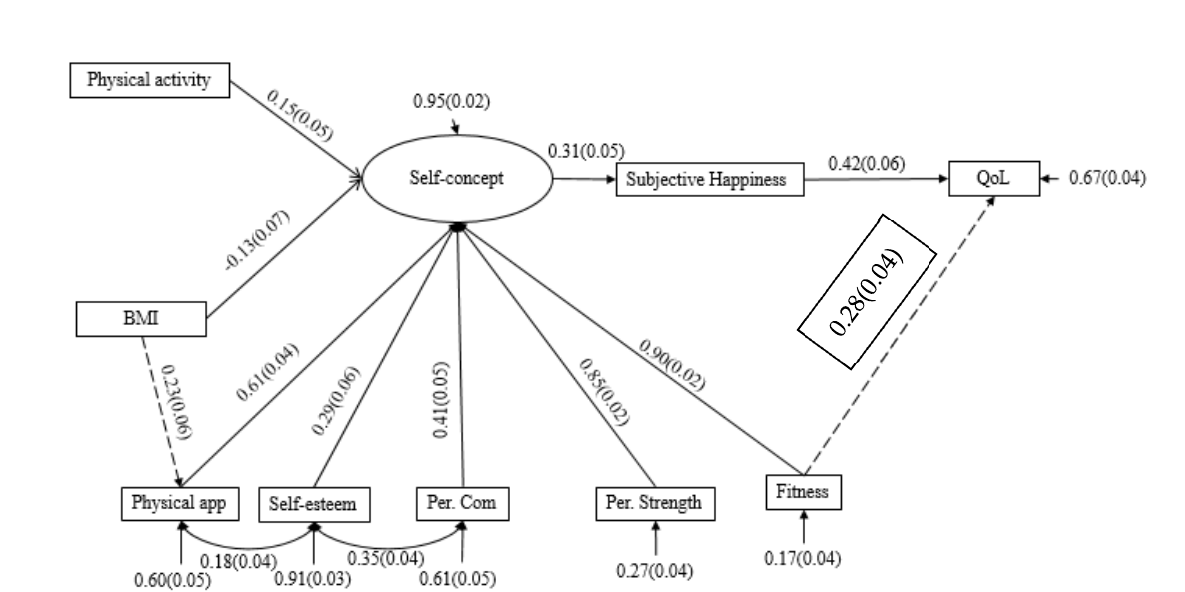
Figure 2. Structural equation model. Note. QoL: quality of life; BMI: body mass index, physical app: physical appearance, per.com: perceived competence; per strength: perceived